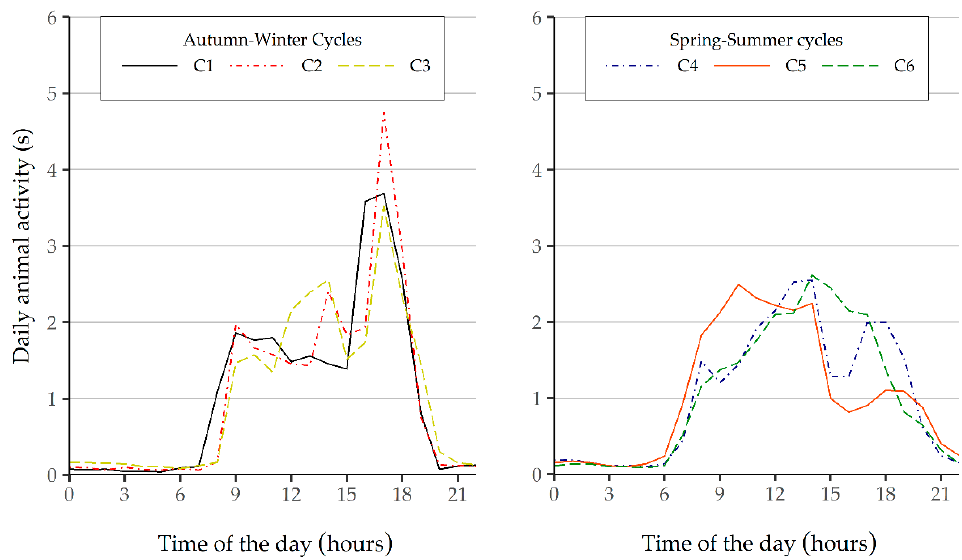
Figure 4. Seasonal component of the multiplicative decomposition of the series of animal activity for autumn–winter and spring–summer cycles.